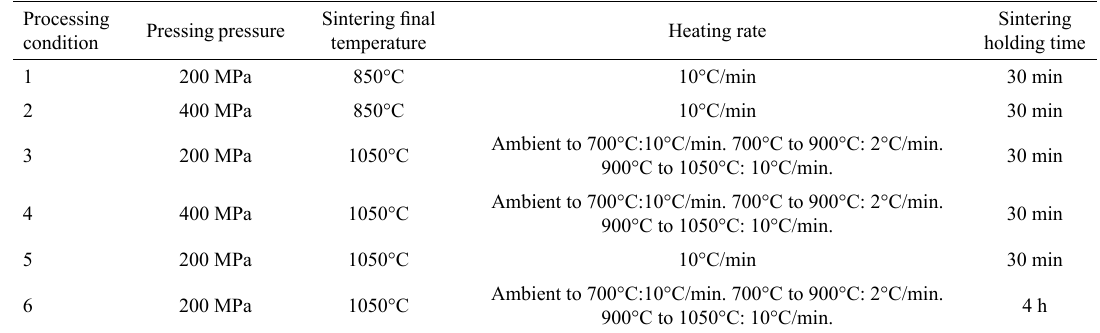
Table 1. Summary of the processing parameters. Processing